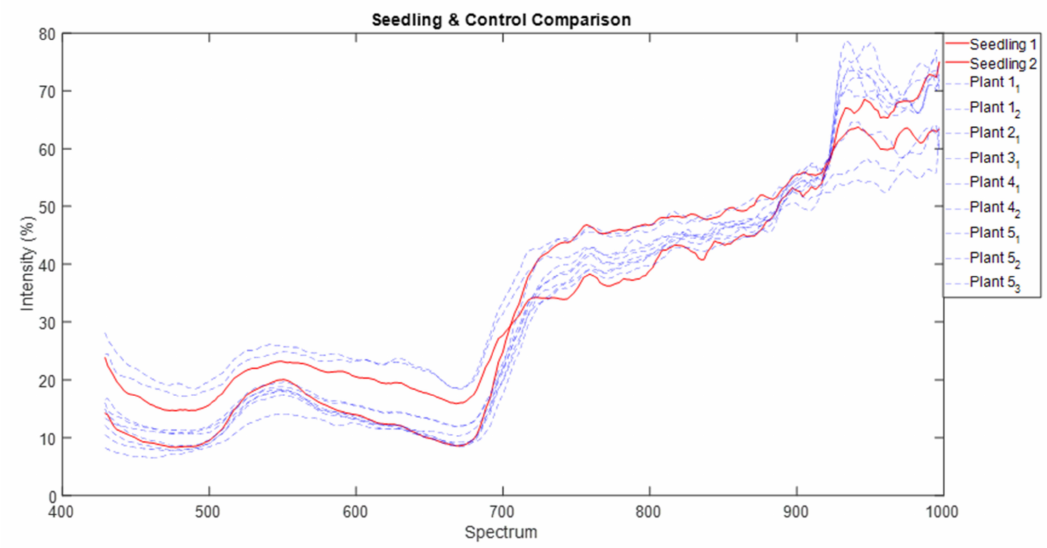
Figure 14. Spectral signature of the seedling stage of parthenium weed compared to the non- parthenium/control plants (Plant 1–Plant